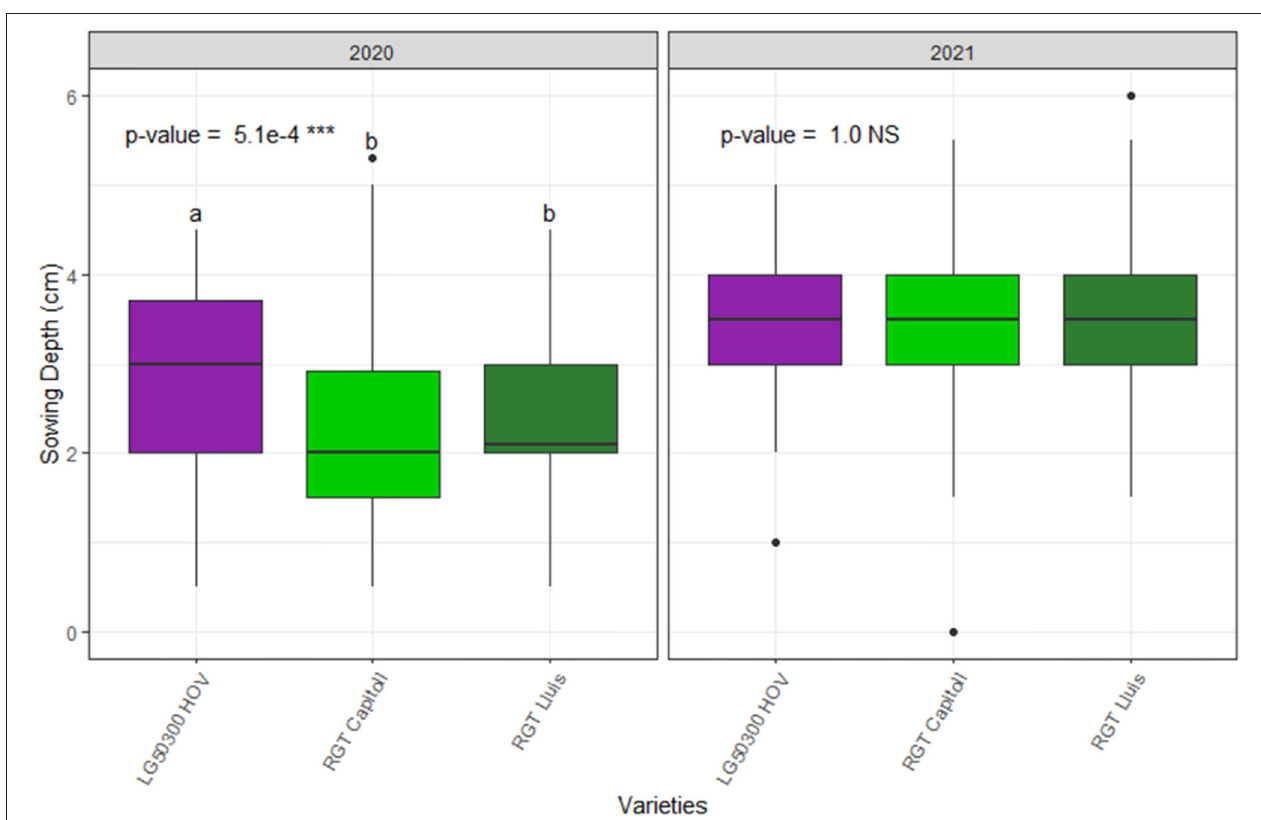
FIGURE 4 | Average sowing depth of three hybrid oilseed varieties of sunflower under field conditions over the two experimental years, 2020 and 2021 at the Auzeville experimental station. Vertical bars reported in the figures represent confidence intervals. The different letters indicate a significant difference between the tested